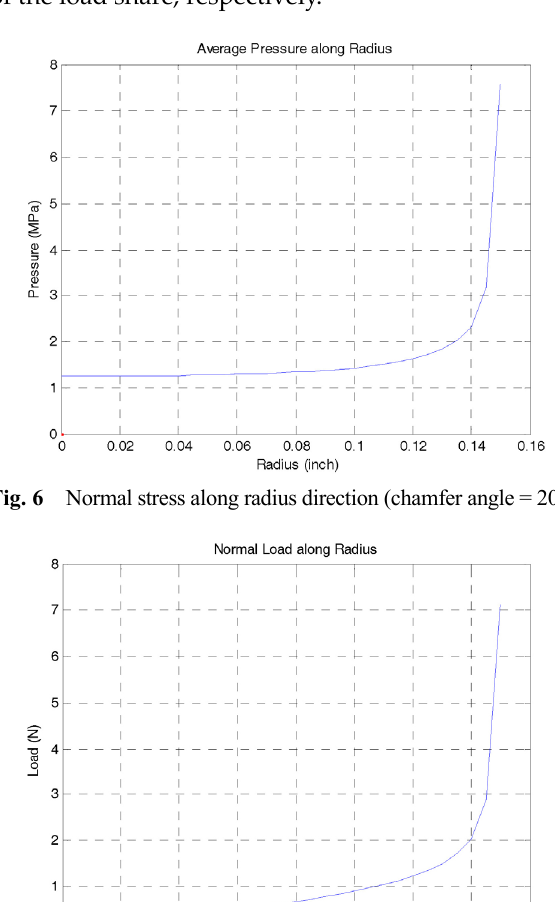
of the load share, respectively.